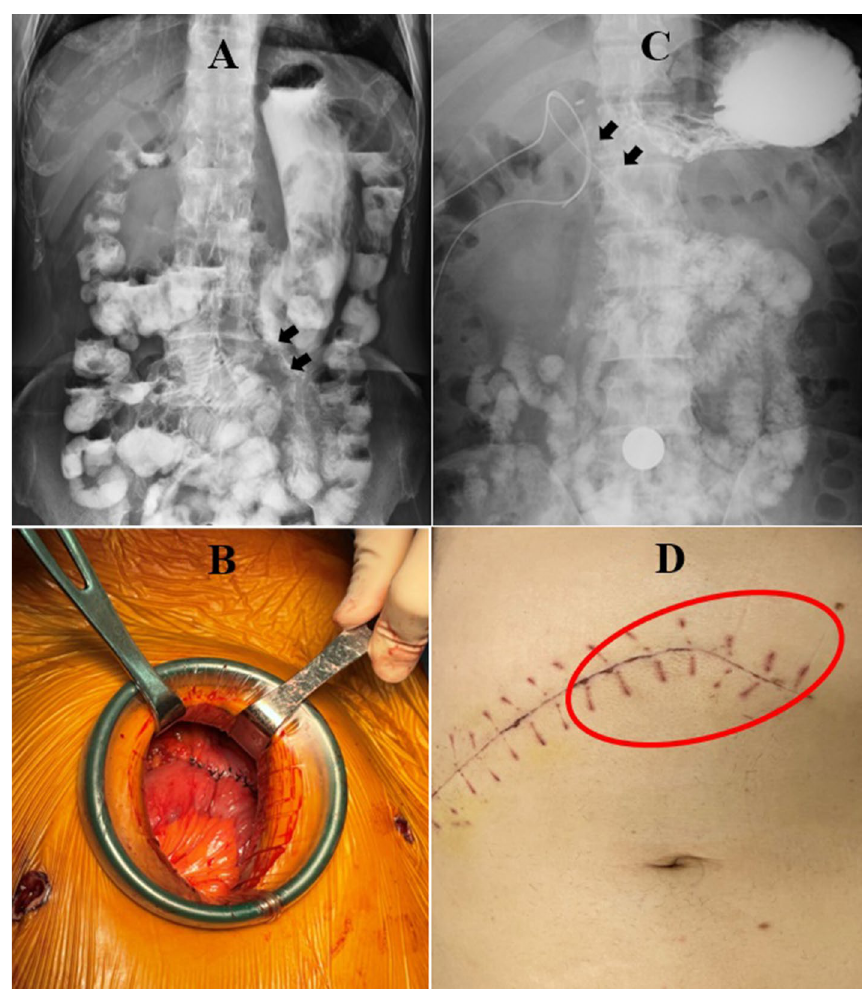
Figure 2. ( A ) The relatively vertical and straight stomach in position and the gastrojejunostomy (indicated by 2 black arrows) near the umbilicus region. ( B ) The last anastomosis in RPD hand-sewn gastrojejunostomy performed using the extracorporeal approach, involving careful downward positioning of the stomach. The final position of stomach and gastrojejunstomy is antecolic, antiperistaltic, and inframesocolic. ( C ) The relatively horizontal stomach in position and the gastrojejunostomy (indicated by 2 black arrows) near the pancreaticojejunostomy (indicated by 2 opacified drains) and above the transverse colon (colon gas inside) after OPD. ( D ) The large abdominal incision wound after OPD. The jejunal limb is pulled upward for gastrojejunal anastomosis, and the final position of the stomach (indicated by a red ovoid circle) and gastrojejunostomy is antecolic, antiperistaltic, and supramesocolic, just beneath the large abdominal incisional